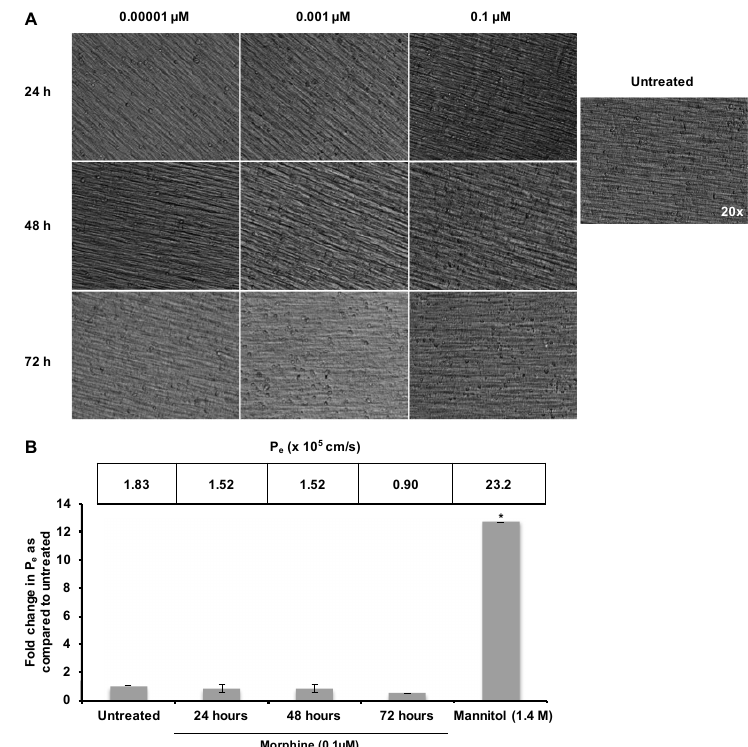
Figure 1. Morphine did not induce leakiness of the hCMEC/D3 barrier. ( A ) hCMEC/D3 cells were cultured for 10 days on 0.4 µM porous polytetrafluoroethylene (PTFE) transwell inserts. The confluent monolayer was then exposed to morphine (0.1 µM) for 24, 48, or 72 h with morphine additions every 24 h to maintain drug concentration. No changes in cellular morphology were observed. Monolayers incubated in the absence or presence of morphine were visualized under 20× Relief Contrast Microscopy using an Olympus (Center Valley, PA, USA) IX81 deconvolution microscope; ( B ) hCMEC/D3 cells were cultured and treated as in panel A. Permeability was assessed by determining the amount of 70 kDa fluorescein isothiocyanate–dextran (FITC-D) to pass from the upper to lower chamber over 30 min, and the permeability coefficient ( P e ) was calculated. Results show that treatment with morphine does not cause general, non-specific leakiness of the monolayer.